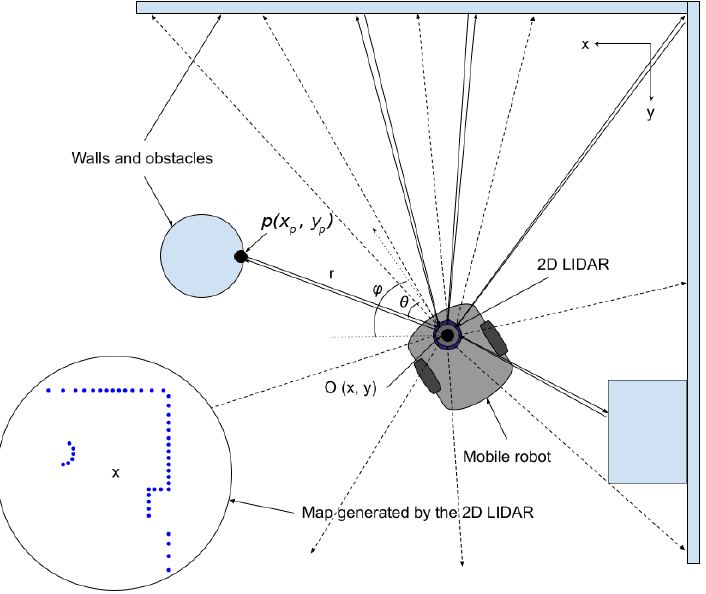
Figure 1. A simplified scheme of 2D Lidar’s